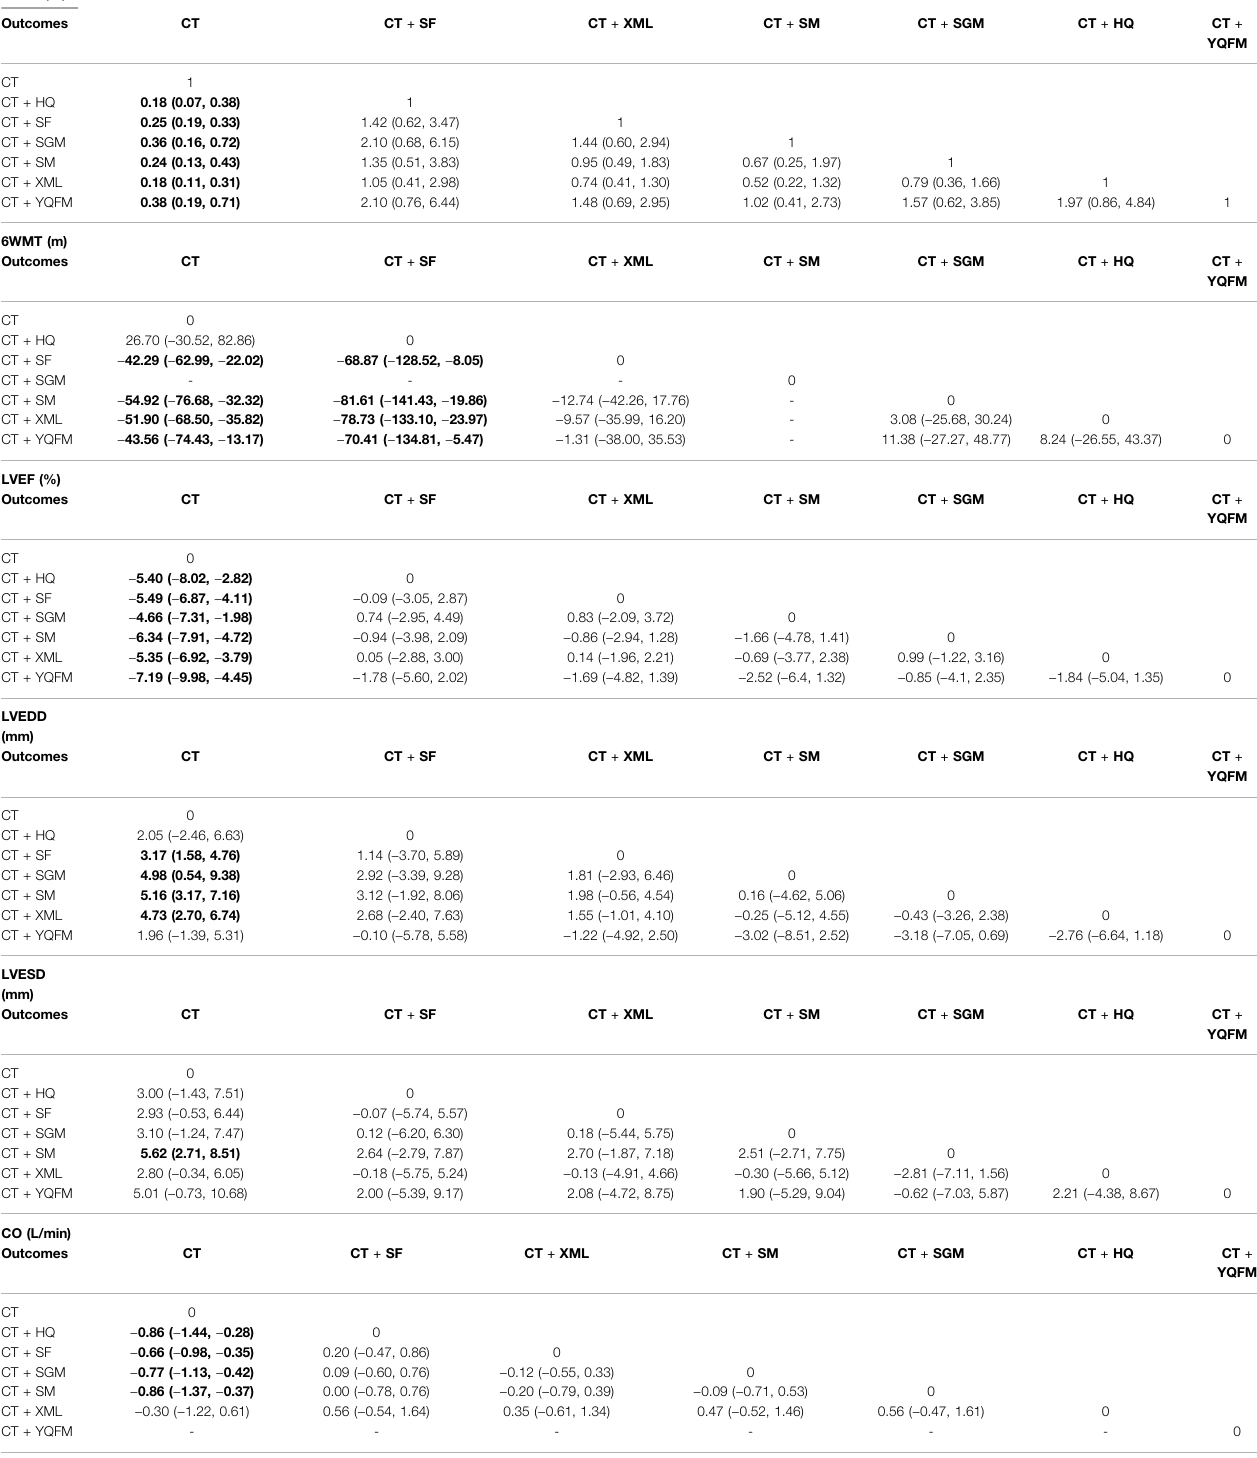
TABLE 2 | Odds ratio/weight mean difference (95% credible interval) results of the network meta-analysis. NYHA (%)